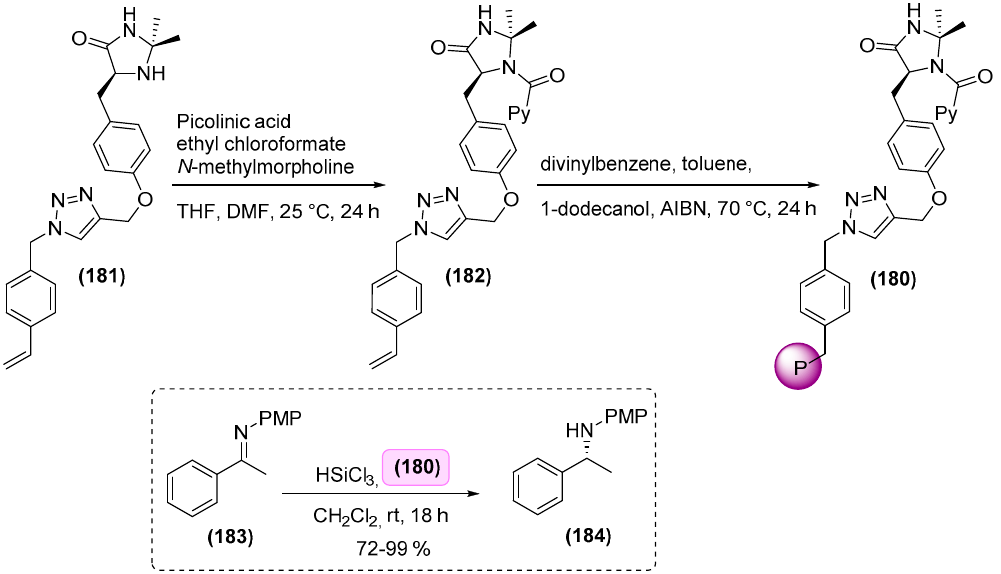
Scheme 34. Synthesis and catalytic evaluation of a polymer-supported picolinamide.